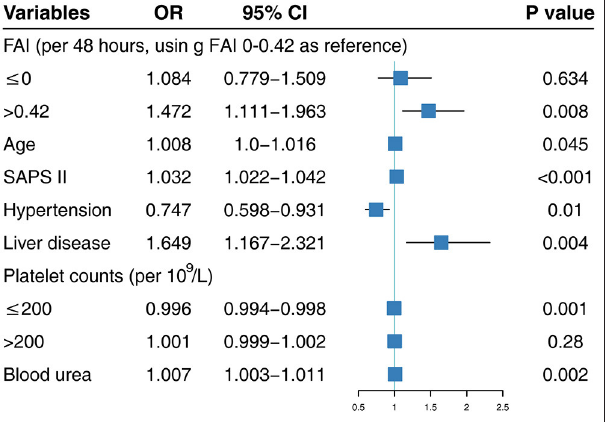
FIGURE 2 | Multivariable logistic regression using designed variables. SAPS II, Simplified Acute Physiology Score II; FAI, fluid accumulation index; OR, odds ratio; CI, confidence